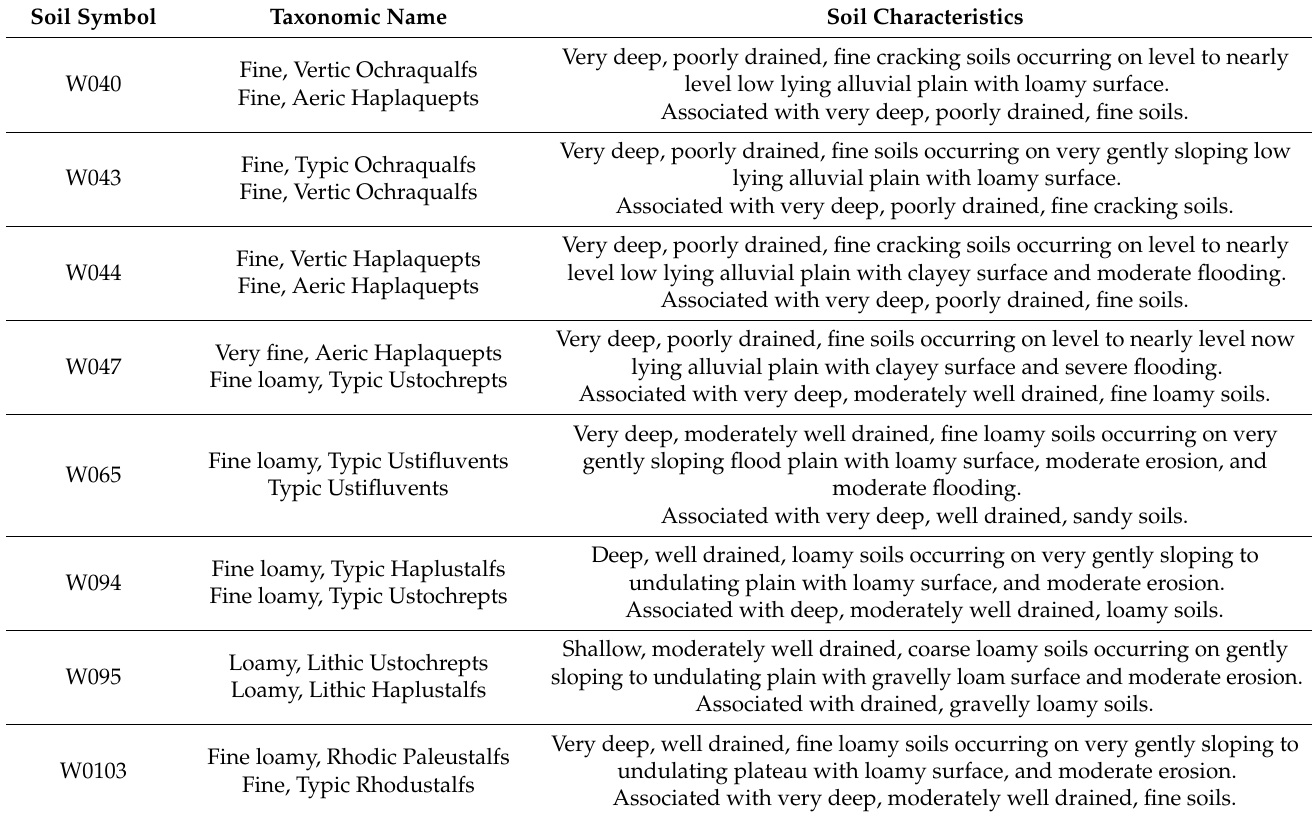
Table 2. Characteristics of soil in the study